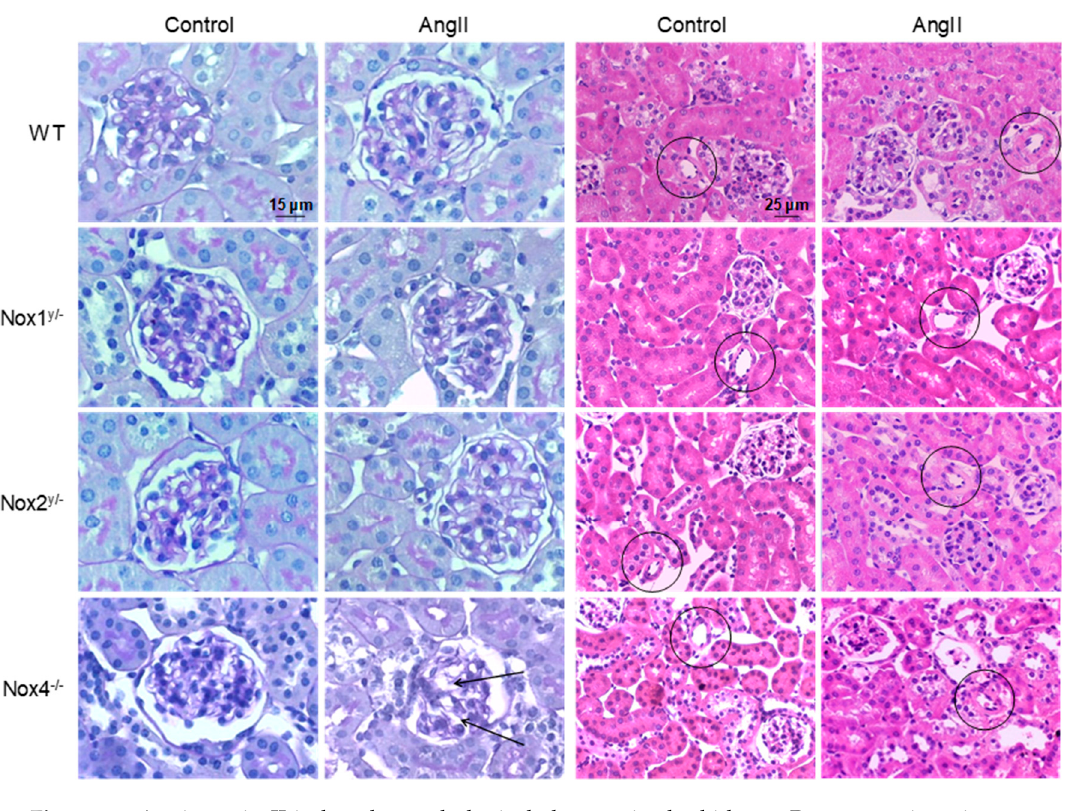
Figure 2. Angiotensin II-induced morphological changes in the kidney. Representative pictures of kidney slices of all animal groups. The two columns on the left (400-fold magnification) show PAS-stained tissue, the arrows point to dilated vessels in the glomerulus, caused by the loss of mesangial matrix. The two columns on the right (200-fold magnification) show HE-stained tissue, the circles highlight small vessels, which have thicker vessel walls in all angiotensin II-treated groups except in Nox1 knockout animals.